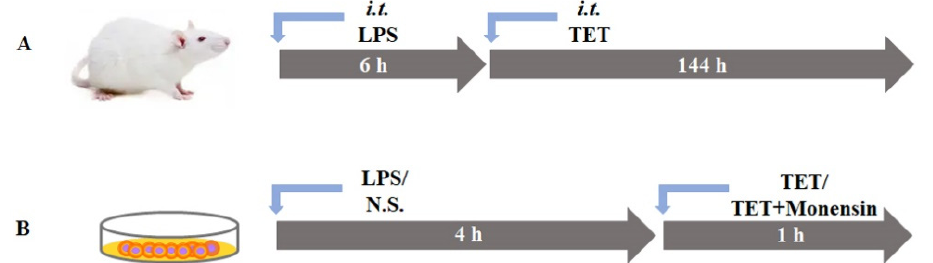
Figure 6. The schematic diagram of the LPS-induced ALI mice model for PK and biodistribution investigation ( A ) and various LPS-treated cell models to investigate cellular accumulation by lysosomal trapping ( B ).